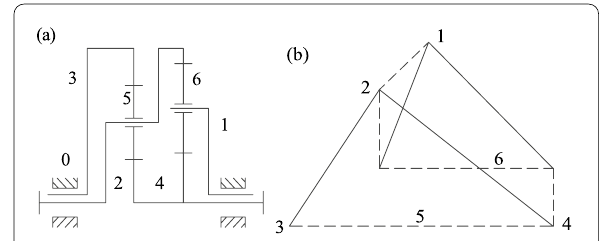
Figure 4 Geometric model of PGTs with four fundamental circuits (dashed line segment connecting 1 and 2 is an auxiliary line): a Functional diagram, b Geometric